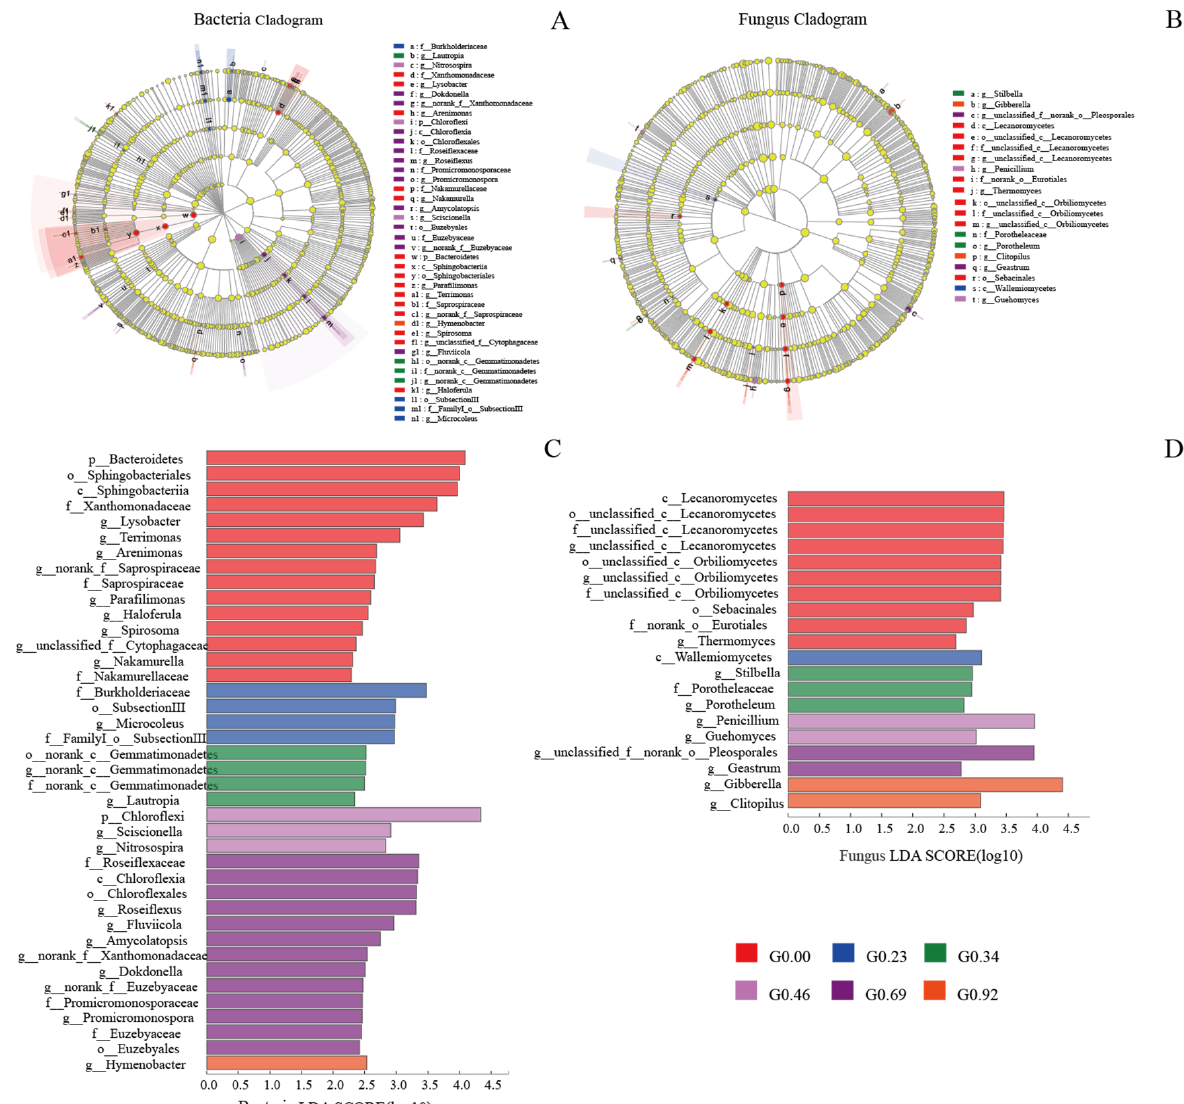
Figure 5. Phylogenetic distribution of the bacterial and fungal lineages associated with soils from different grazing intensities (cladogram) ( A , B ). Indicator bacteria with LDA scores of 2 or greater in bacterial and fungal communities associated with soils from different grazing intensities ( C , D ). Different-colored regions represent different constituents. Circles indicate phylogenetic levels from the domain to the genus. The diameter of each circle is proportional to the abundance of the group. Different-colored regions represent different grazing intensities.